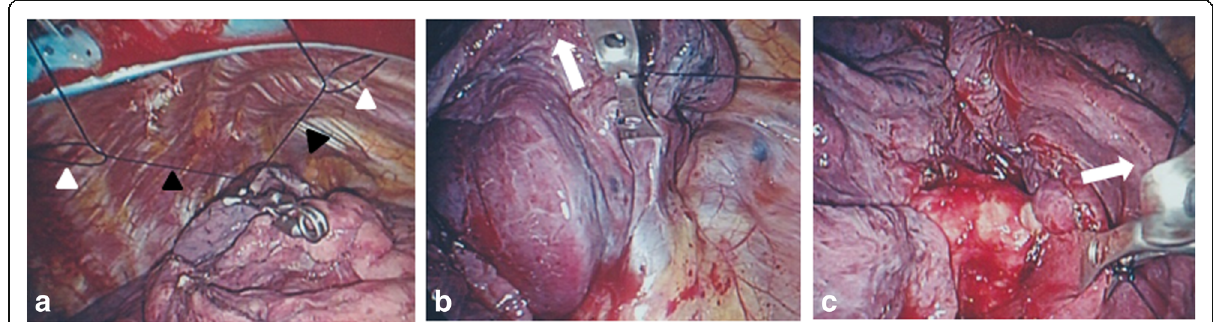
Fig. 4 Intraoperative views of the modified marionette technique. a The looped 1-0 nylons working as pivots were pierced through the chest wall (white arrow heads). The 1-0 nylons attached to the IOR were drawn out separately form the access port (black arrow heads). b When the left nylon attached to the IOR was pulled, the IOR retracted the lung upward toward the left-side looped nylon. White arrows indicate the direction of traction. c When the right nylon attached to the IOR was pulled, the IOR retracted the lung upward toward the right-side looped